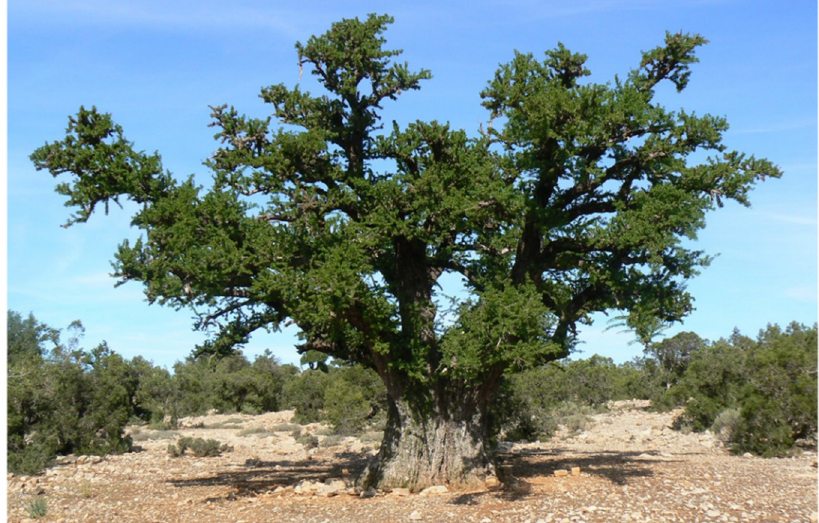
Figure 1. General aspect of the argan tree ( Argania spinosa (L.) skeels). During the argan-oil extraction process, two by-products are generated: fruit pulp and press cake. These by-products are used by the Moroccan Berber population for tanning skins, cattle grazing, and skin care. The pulp and cake’s biological properties have been reported in many ethnobotanical surveys. In contrast with argan fruit shells, they are also easier to study due to their friable structure, which greatly facilitates the extraction of secondary metabolites. Moreover, several studies have suggested the presence of very interesting dermocosmetic properties [10–12].